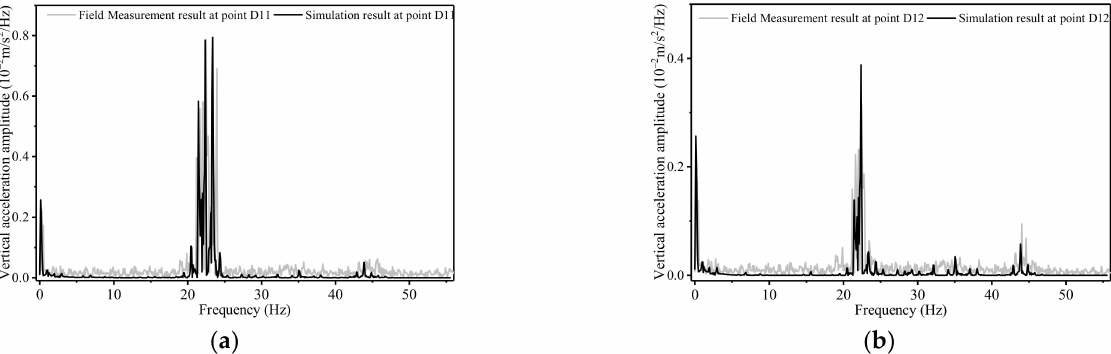
Figure 8. Vertical acceleration at point D12. ( a ) Numerical model result; ( b ) Field measurement result.